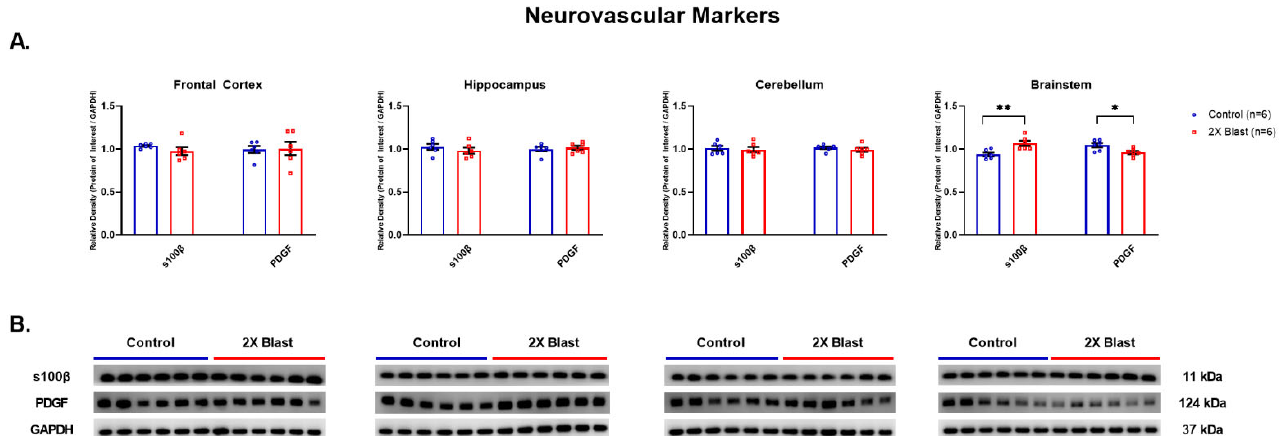
Figure 5. Neurovascular related protein expression changes. ( A ) Densitometric ratio of the levels of S100 β and PDGF with respect to GAPDH as measured in the FCtx, H, CRB and BS 15 days following an explosive ‐ driven double blast exposure, n = 6 per group, *indicates p values < 0.05 and ** indicates p values <0.01 as determined by 2 ‐ tailed, unpaired t ‐ tests. Error bars represent standard error of the mean (SEM). ( B ) Representative western blots # for each antibody used. All gels were run in triplicate and data represents the average of 3 runs per sample. # For full length blots, see Supplementary Figures S10 and S11.